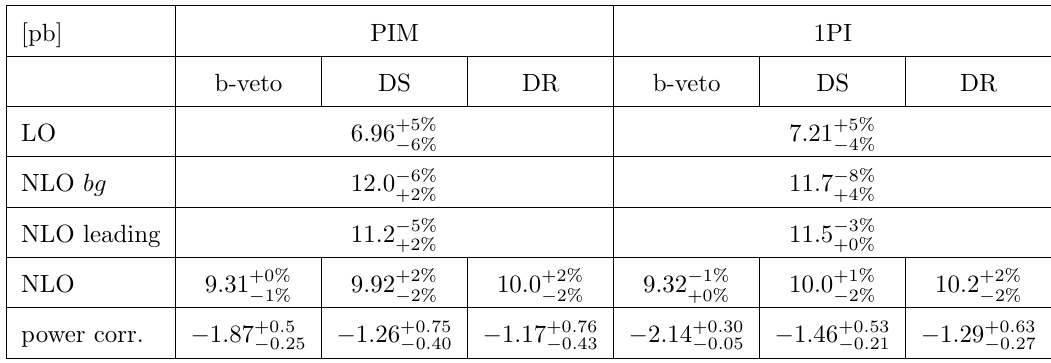
Table 1 . The (cid:12)xed-order total cross section and the power corrections for tW (cid:0) production with p s = 8 TeV. The power corrections are de(cid:12)ned as d(cid:27) (NLO) di(cid:11)erent in two schemes due to the di(cid:11)erent choice of the factorization scale. The scale uncertainties are shown.